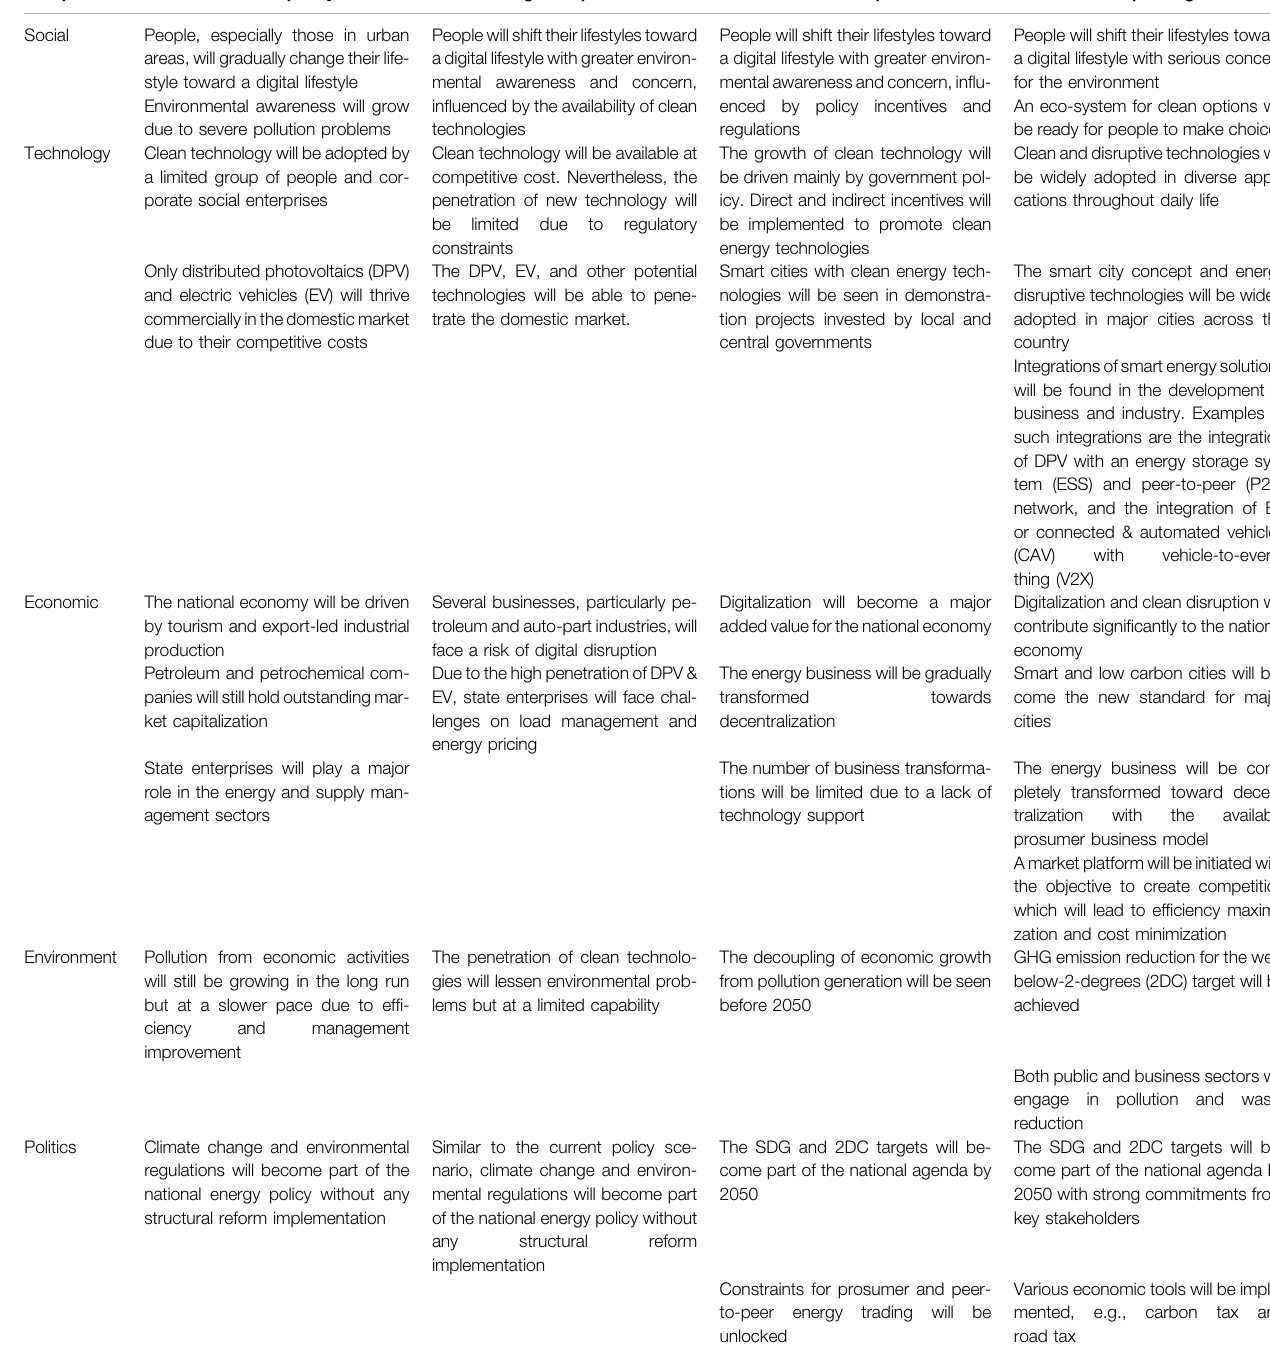
TABLE 2 | Narratives of plausible scenarios for Thai energy business toward SDG in